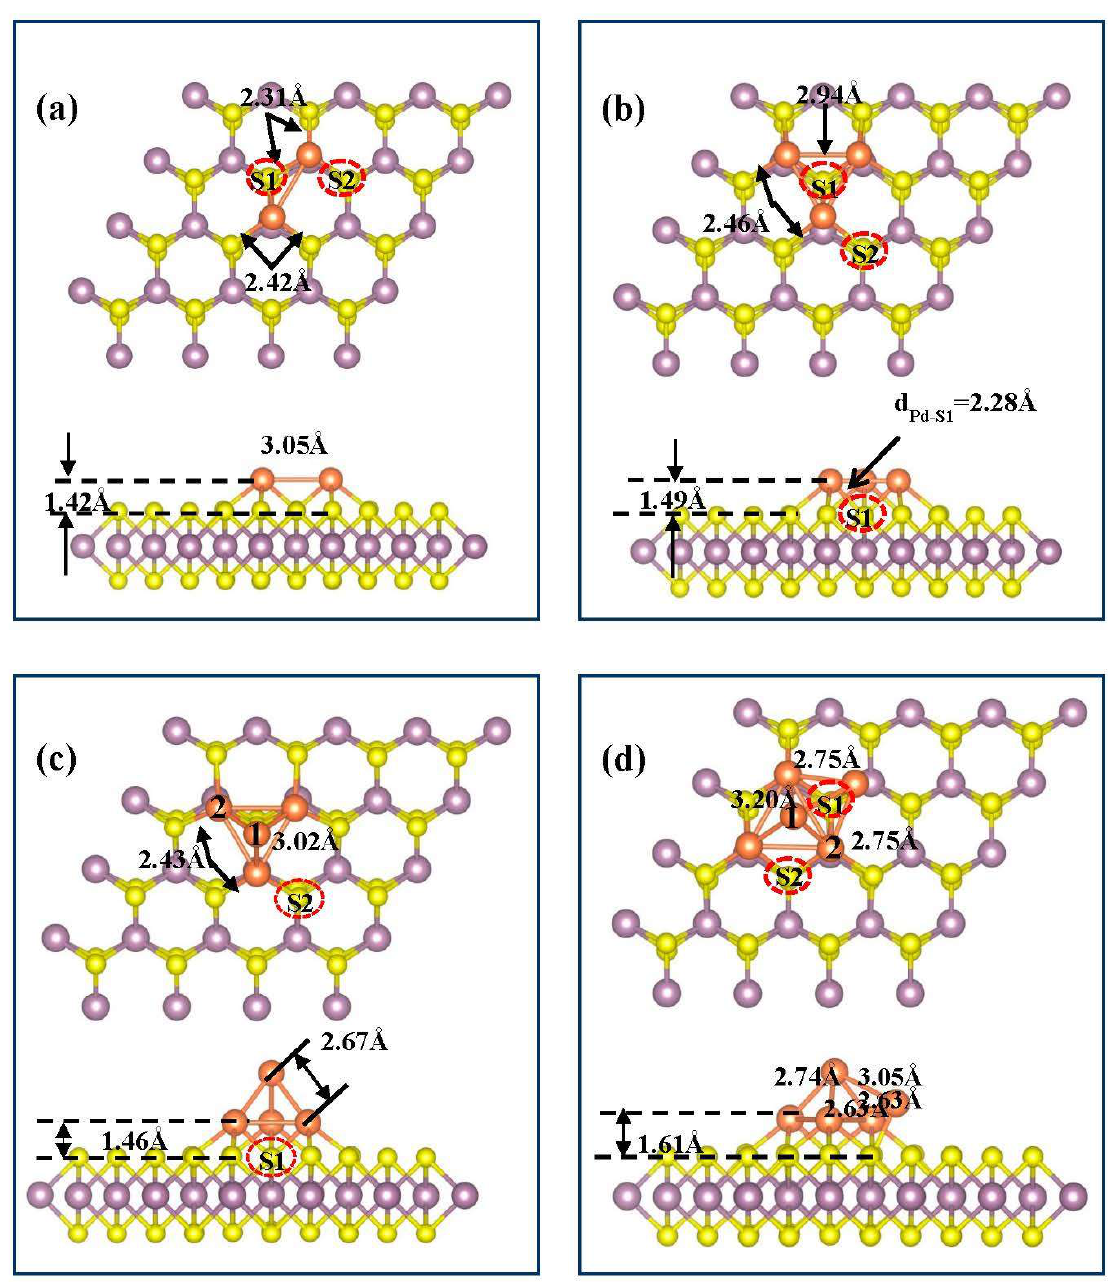
Figure 2. ( a – d ) Top and side views for most stable configurations of palladium dimer, trimer, tetramer, and pentamer adsorbed at the MoS 2 monolayer, respectively. The yellow, lavender, and orange balls represent S, Mo, and Pd atoms, respectively.